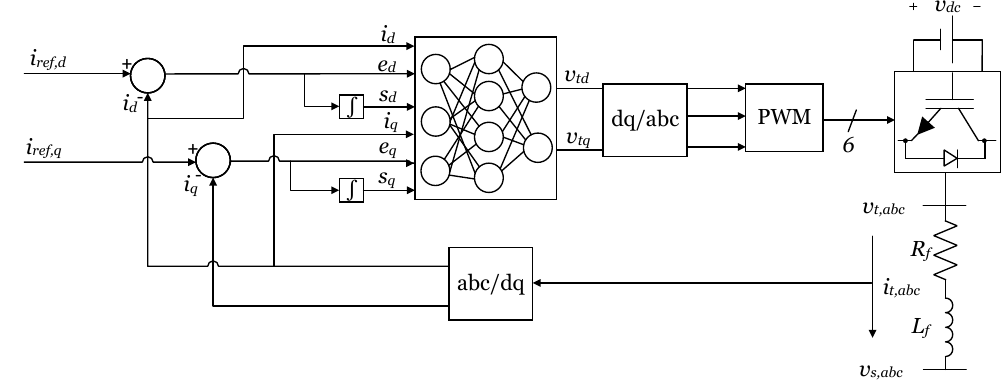
Figure 4. LSTM control structure for grid-connected VSC.